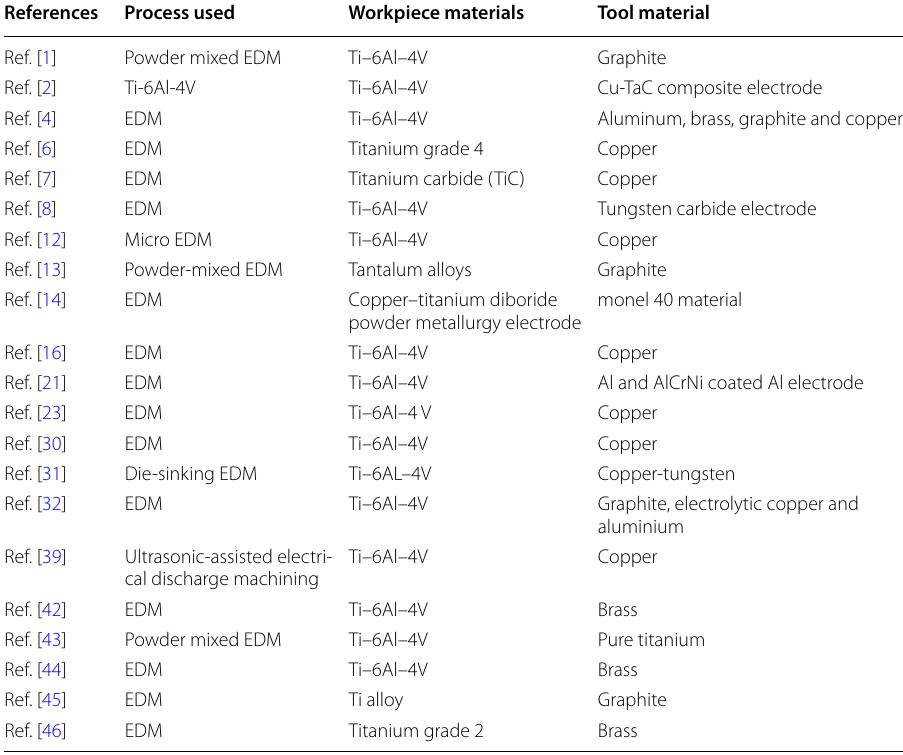
Table 3 Summary titanium alloy by EDM